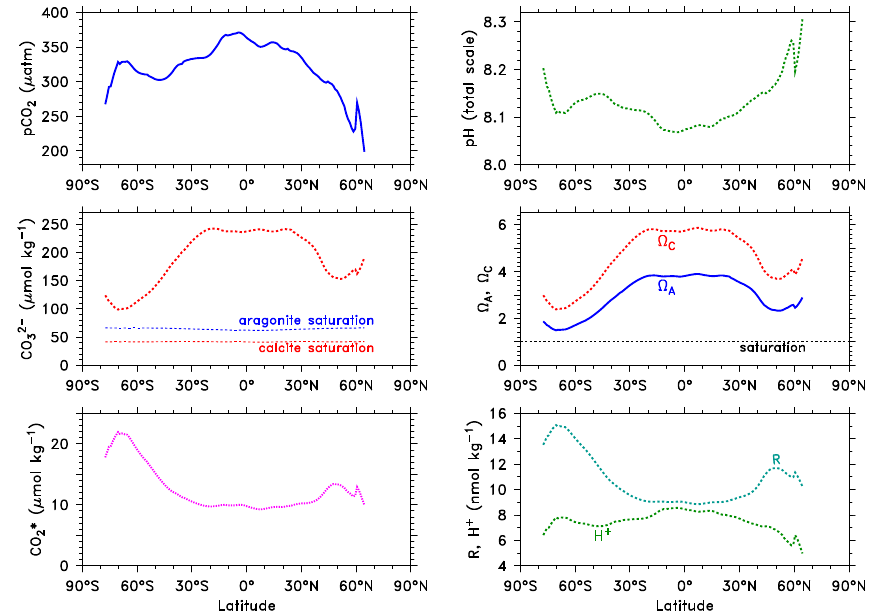
Figure 2. Surface zonal means of carbonate system variables computed with mocsy 2.0 from the gridded GLODAP data for A T and C T combined with corresponding data from the 2009 World Ocean Atlas for in situ T, S, P T , and Si T